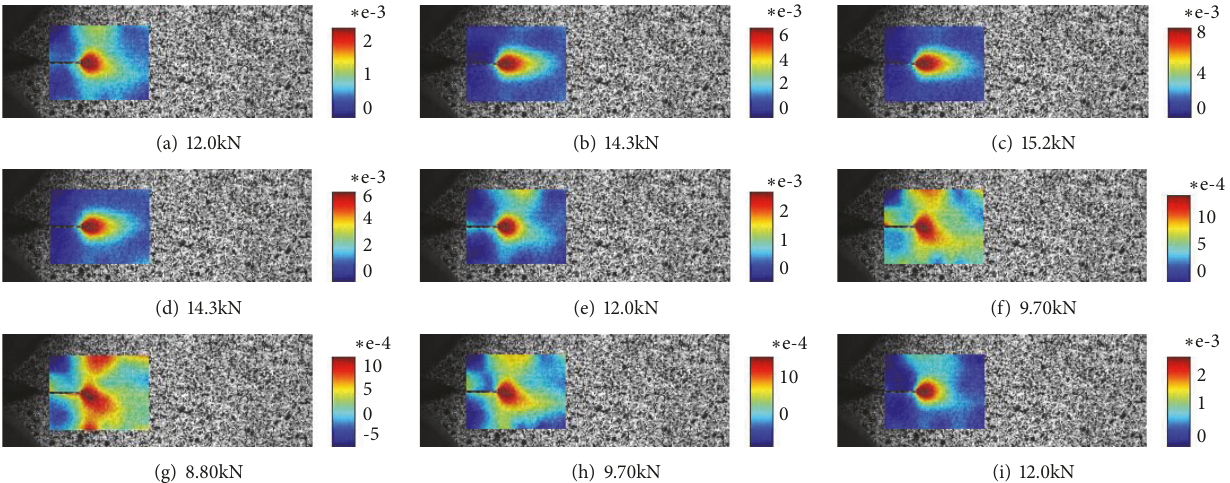
Figure 13: Y-direction strain fields at characteristic load values within one stress cycle with 5.79mm crack.